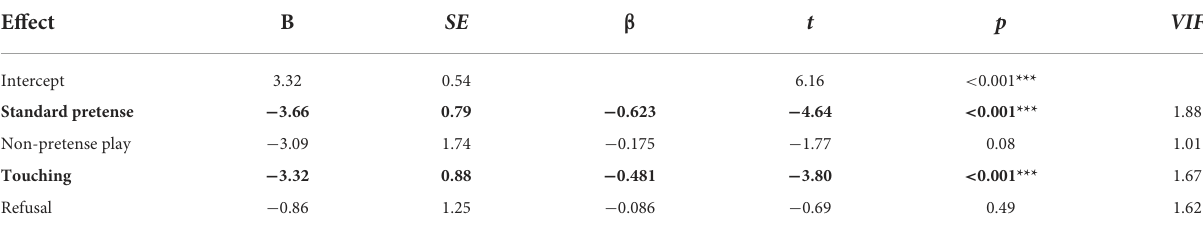
TABLE 3 Coefficients of “standard pretense,” “non-pretense play,” “touching,” and “refusal” in multiple regression analyses and the variance inflation factor (VIF). Effect B Intercept